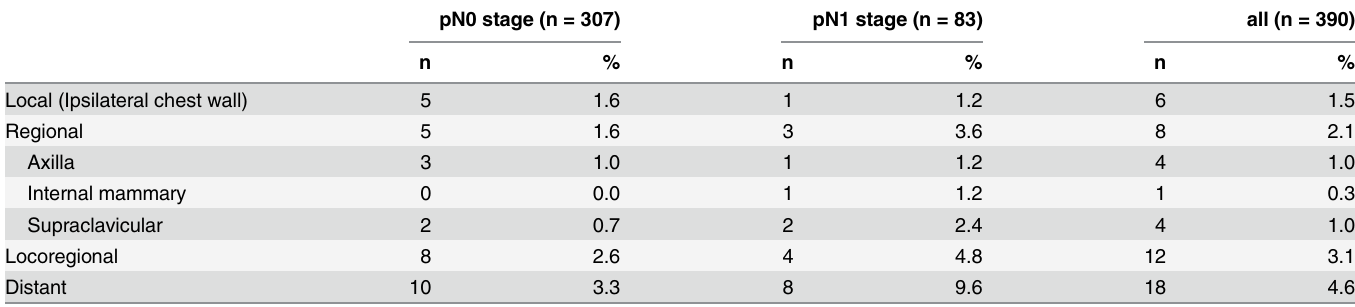
The median follow-up period was 5.6 years (range, 0.6 – 11.3 years). There were six chest wall recurrences, eight regional recurrences, 18 DMs, and 24 deaths that occurred during the fol- low-up period. Table 2 shows the recurrence site patterns. While LR rates were similar between patients with pN0 and pN1, patients with 1 – 3 positive nodes had more recurrences in the supraclavicular area and distant sites. The cumulative incidence of 5-year LR-free survival was Table 2. Recurrence sites as a factor of failures in stage N0, N1 and all